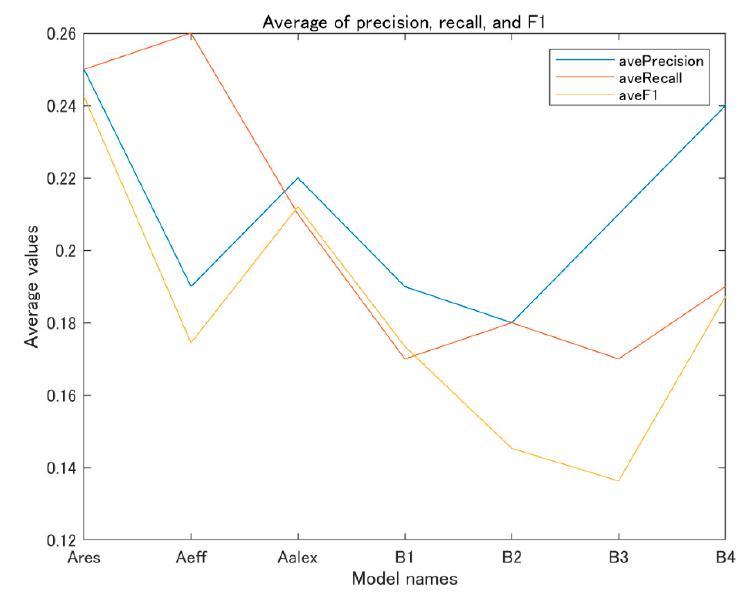
Figure 6. Average of precision, recall, and F1.